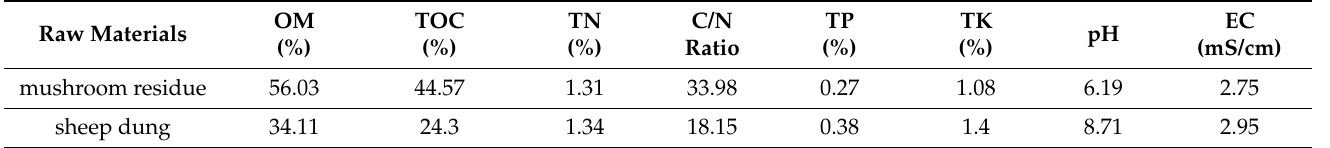
Table 1. The basic physicochemical properties for composting raw materials.